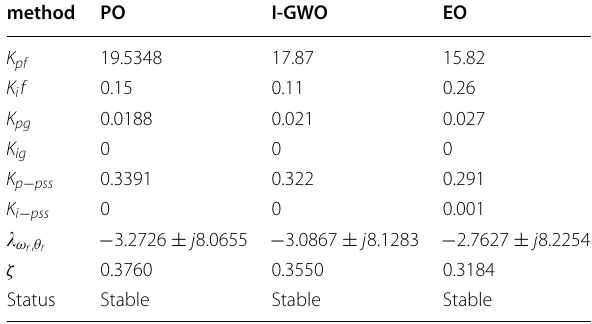
Table 5 The optimal values of PI